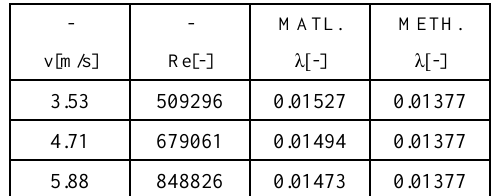
Table 3. Comparison of friction factor for MATLAB and field deployment methodology .